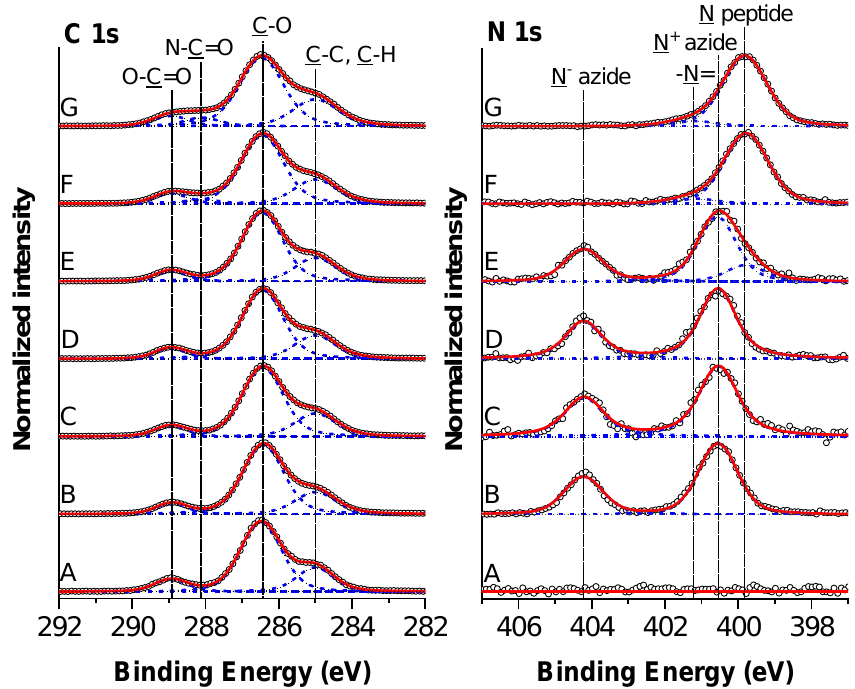
Figure 1. High resolution C 1s and N 1s XPS spectra of polymer brush poly(MeOEGMA- block -GMA) brush grown over Si substrates before ( A ) and after reaction with azide ( B ) and after immobilization of RGD peptide to surface concentration 1.1 nmol / cm 2 ( C ), 12.1 nmol / cm 2 ( D ), 3.2 × 10 2 nmol / cm 2 ( E ), 1.2